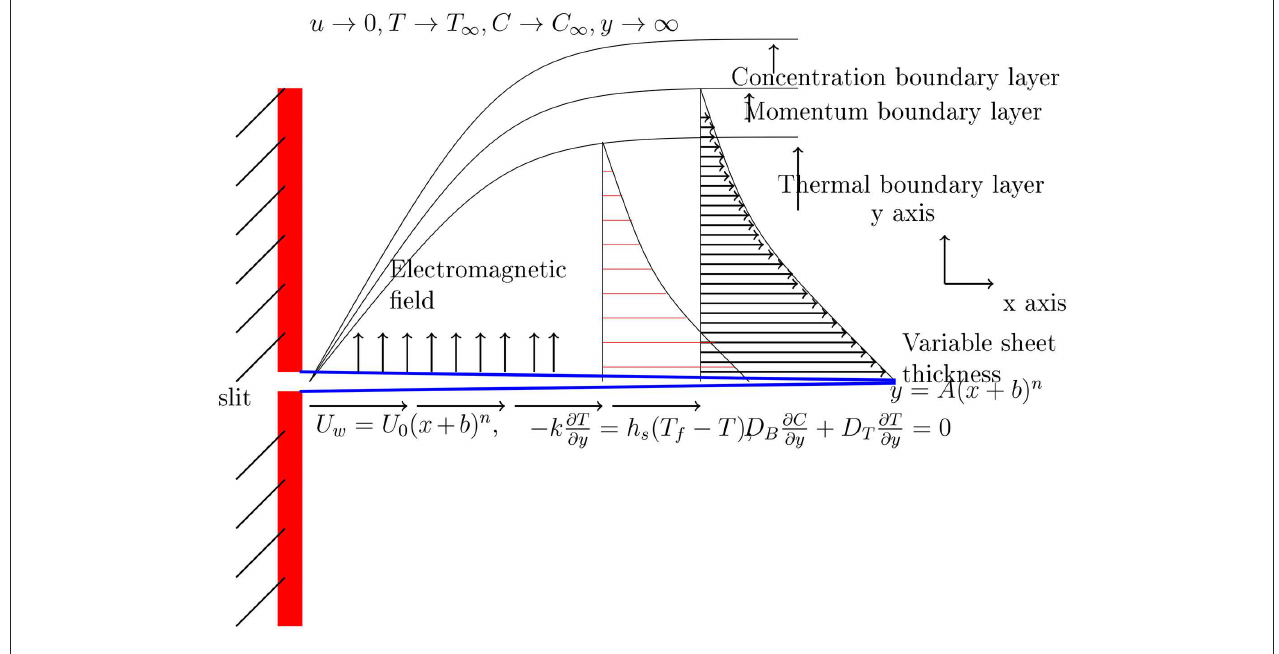
FIGURE 1 | Schematic diagram of the problem.